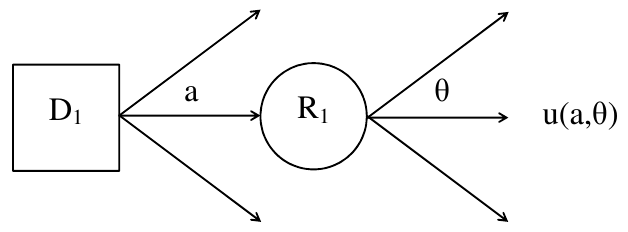
Figure 1. Example of a single-period decision